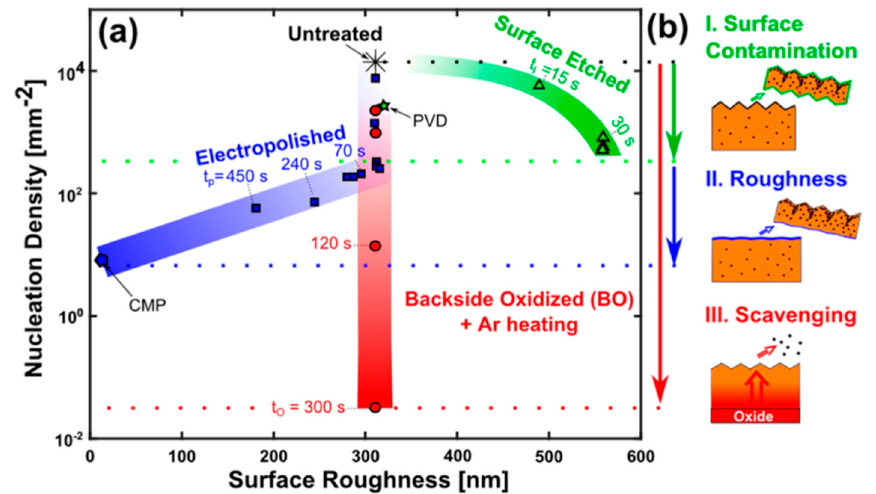
Figure 14. ( a ) overview of Cu pre-treatments and the effect on graphene nucleation density and Cu surface roughness; ( b ) schematic indicating the cause of the reduction in nucleation density for surface pre-treatments I − III (reprinted with permission from [125]).